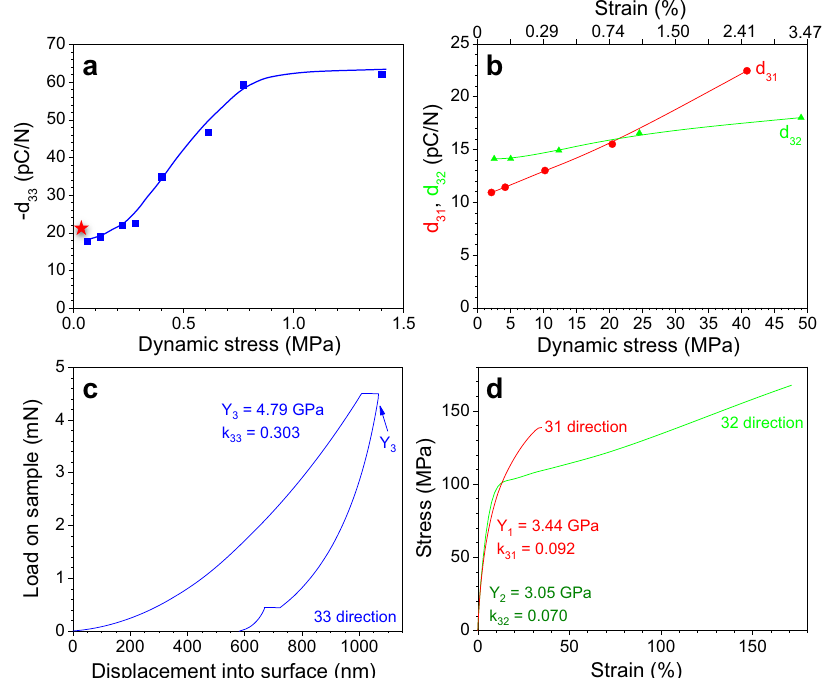
Fig. 3 Piezoelectric and mechanical properties of the poled BOPVDF. Using direct piezoelectric measurement, various piezoelectric coef fi cients are determined: a d 33 and b d 31 , d 32 as a function of dynamic stress for the highly poled BOPVDF fi lm. The red star in a indicates the d 33 value measured by the d 33 piezo meter with a static force of 2.5 N. c Compression modulus (Y 3 ) is determined by nanoindentation, and d tensile moduli ( determined by the stress-strain curves for the highly poled BOPVDF fi lm. The maximum k 3 j ( j = 1, 2, and 3) values are shown in c and d .